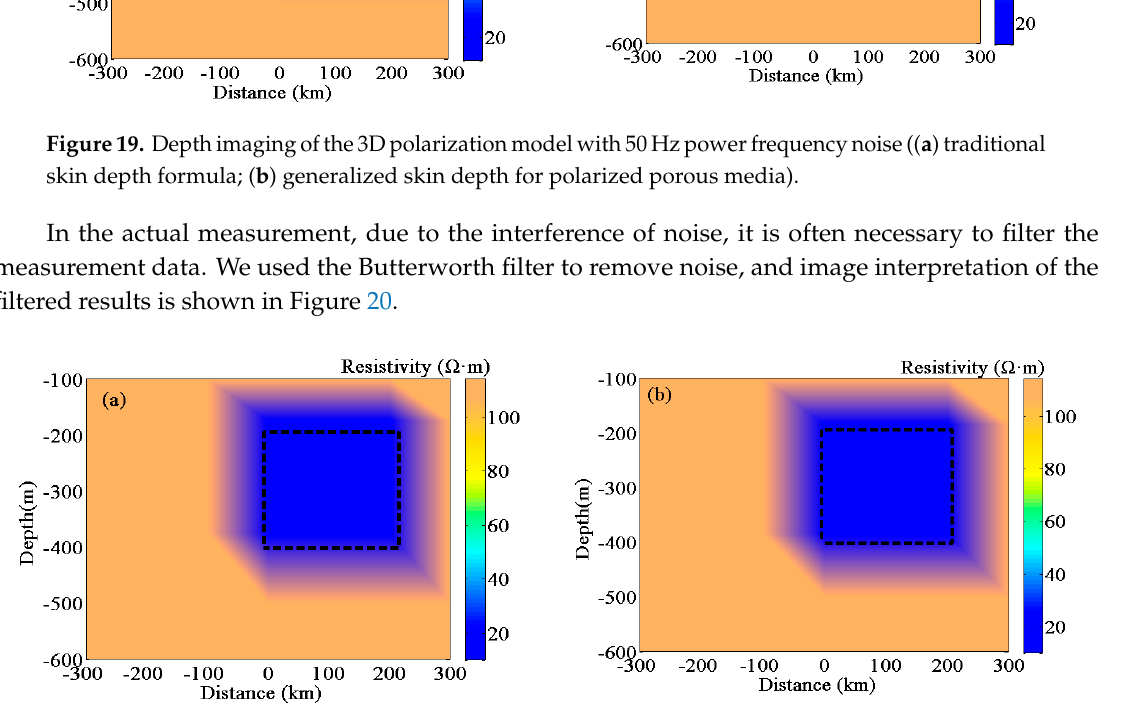
Figure 20. Depth imaging of the 3D polarization model after denoising (( a ) traditional skin depth formula; ( b ) generalized skin depth for polarized porous